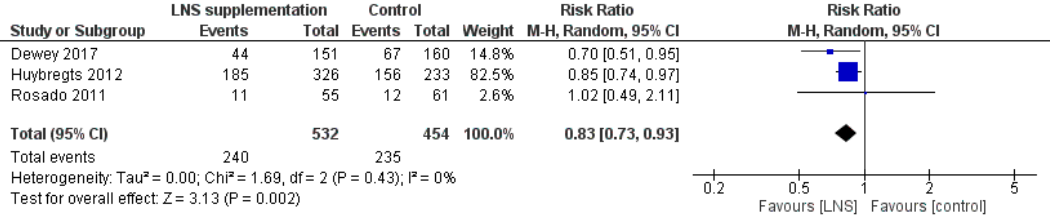
Figure 11. LNS supplementation versus placebo/no intervention (effectiveness studies) on the risk of anemia (hemoglobin concentration < 110 g/L).